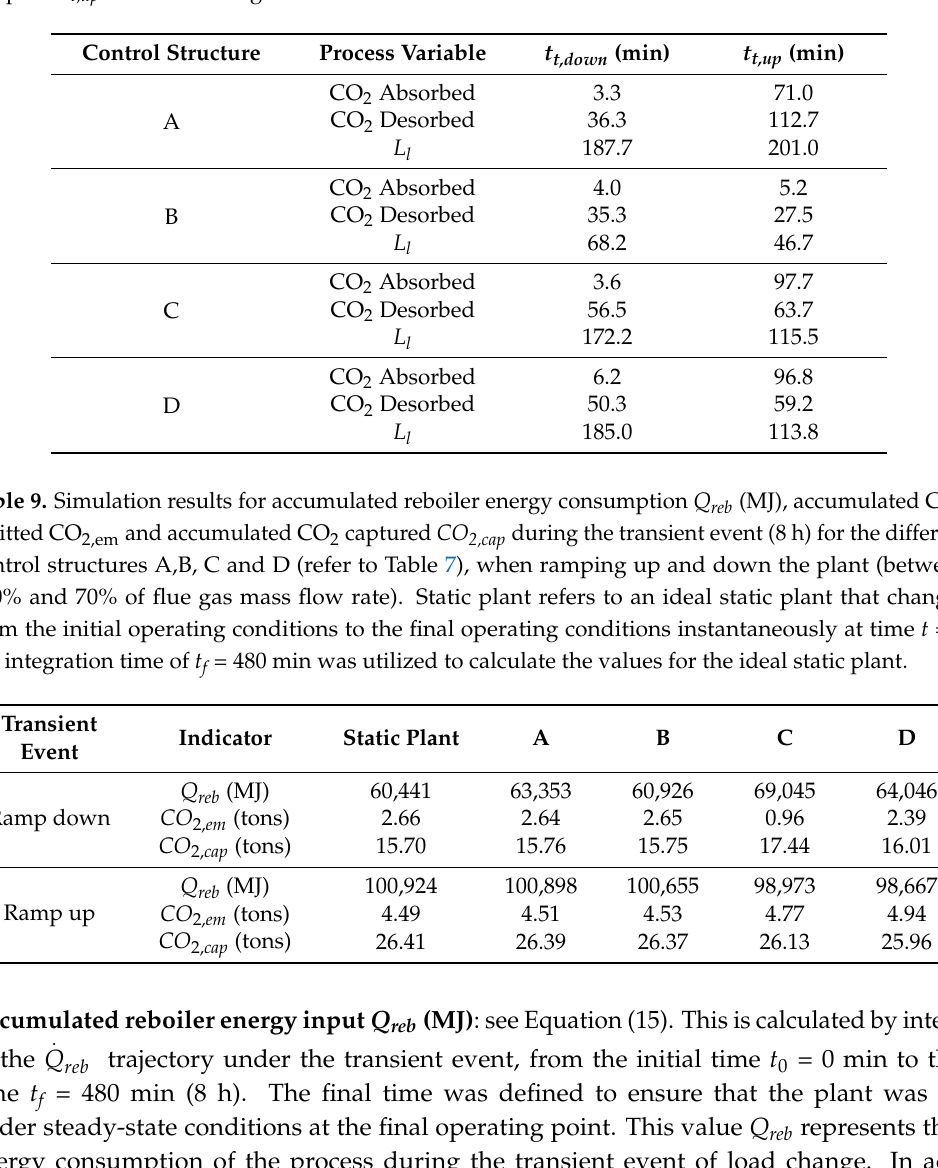
Table 8. Total stabilization times of the floating process variables for the different control structures, when ramping down the plant t t,down from 100% flue gas mass flow rate to 70%; and when ramping up the plant t t,up from 70% flue gas mass flow rate to 100%.